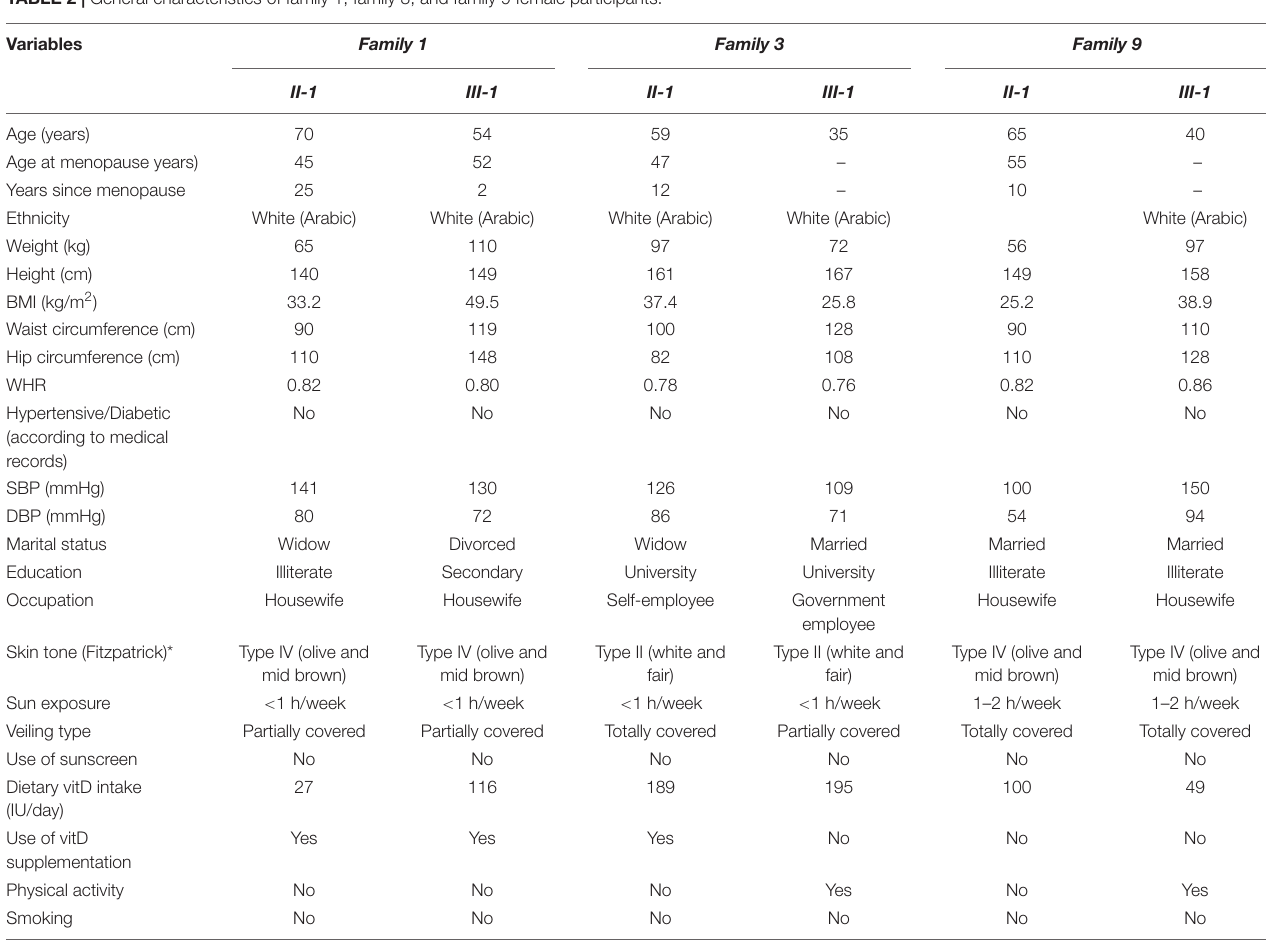
TABLE 2 | General characteristics of family 1, family 3, and family 9 female